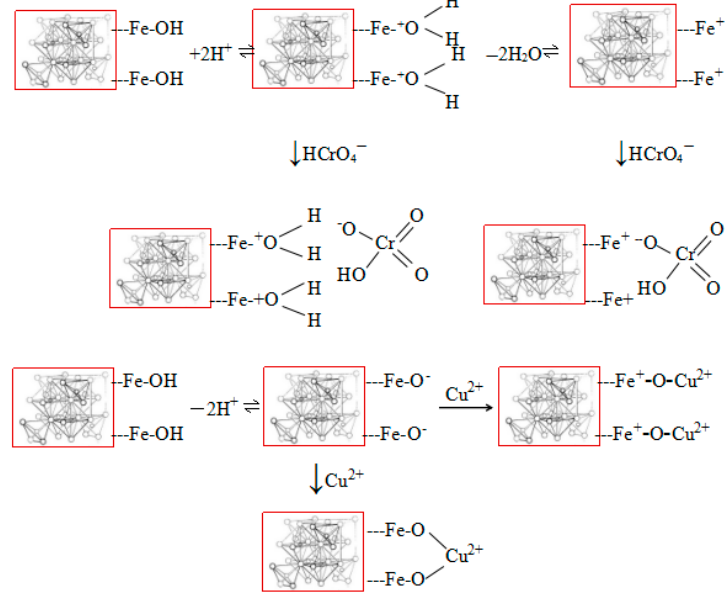
Figure 5. The mechanism of adsorption of Cr(VI) and Cu(II) by Fe 3 O 4.